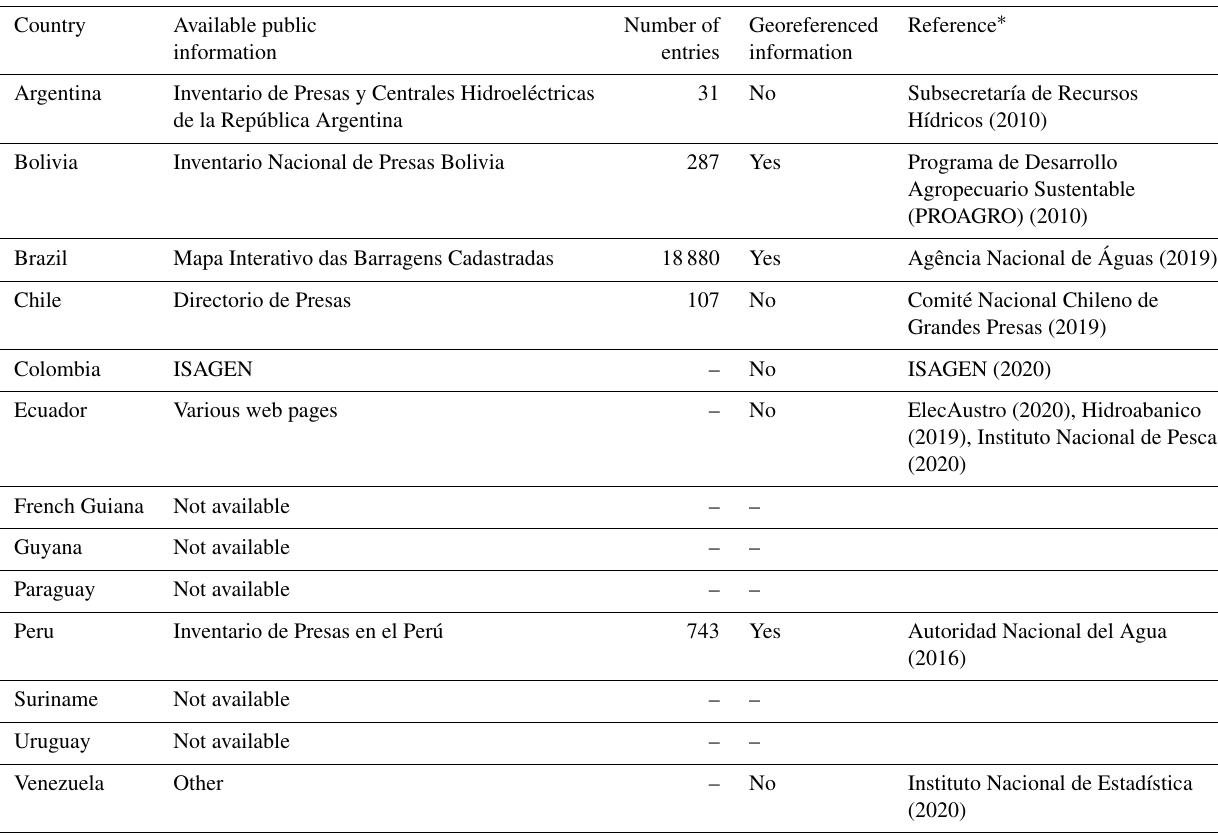
Table 1. Available public data records of dams per country. Country Available public Number of Georeferenced Reference ∗ information entries